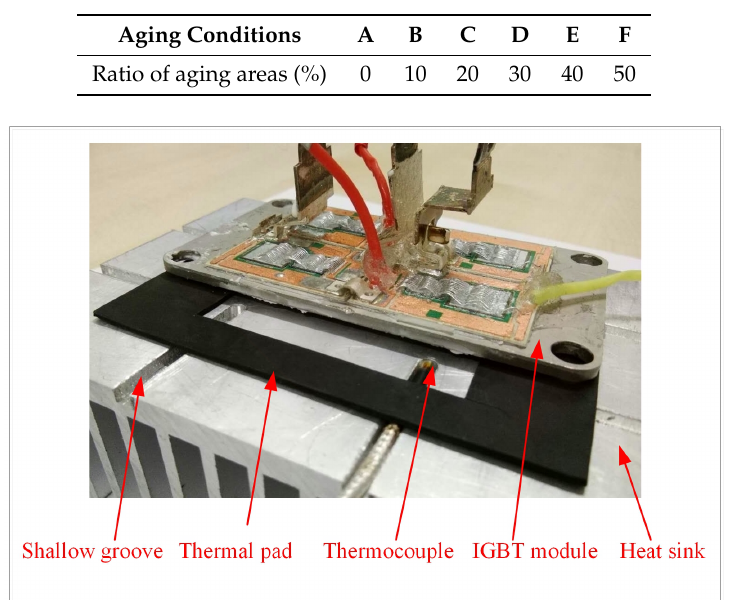
Figure 8. The development of the solder